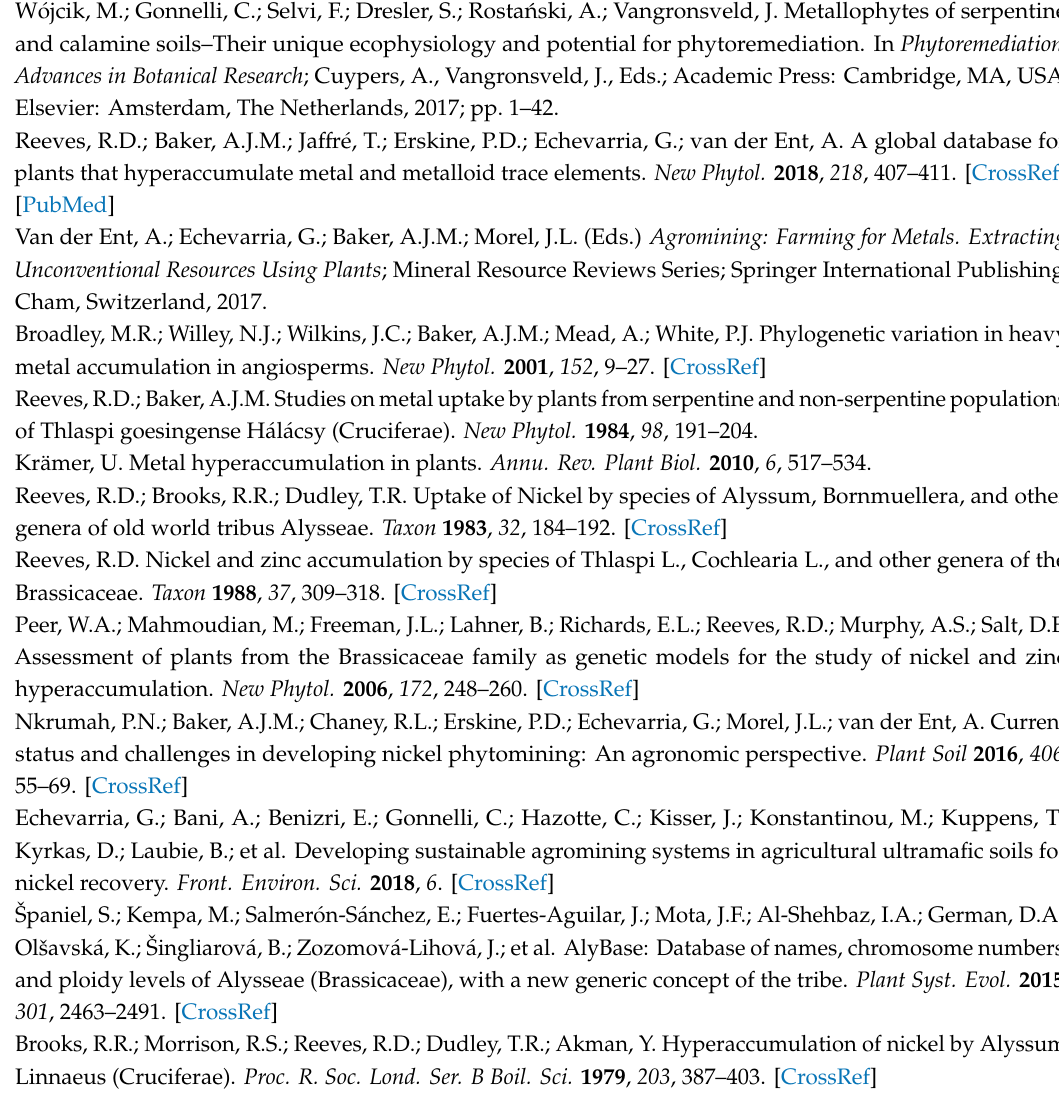
Figure S1: Delta K graph showing optimal number of genetic groups, from STRUCTURE HARVESTER, Figure S2: Neighbor-Net graph of the 374 individual AFLP-profiles from SPLITSTREE, Table S1: List of accessions and taxa of Odontarrhena from Albania used for AFLP analysis, Table S2: List of taxa (in alphabetical order) and accessions included in the phylogenetic analysis, Table S3: Fluorescent labelling, primer name and primer sequence with selective extension, Table S4: Evanno table output and raw Structure